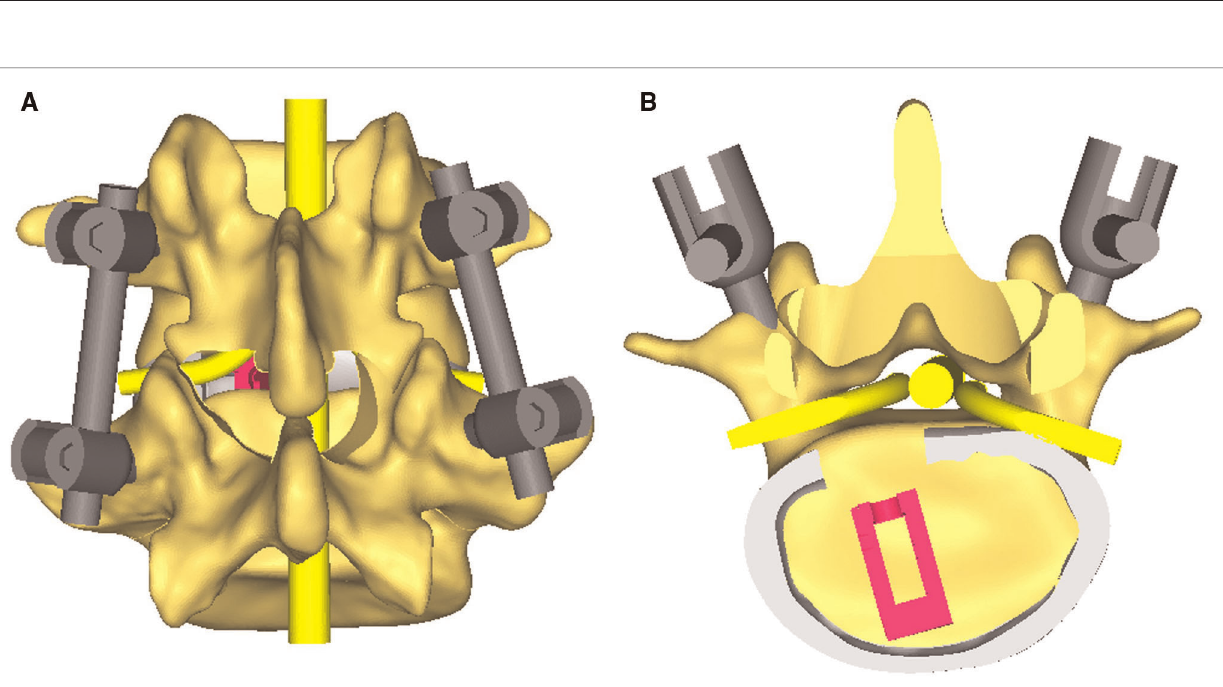
FIGURE 2 | ( A ) A 3D schematic diagram of percutaneous endoscopic posterior lumbar interbody fusion with unilateral laminotomy for bilateral decompression. ( B ) A cross-sectional schematic